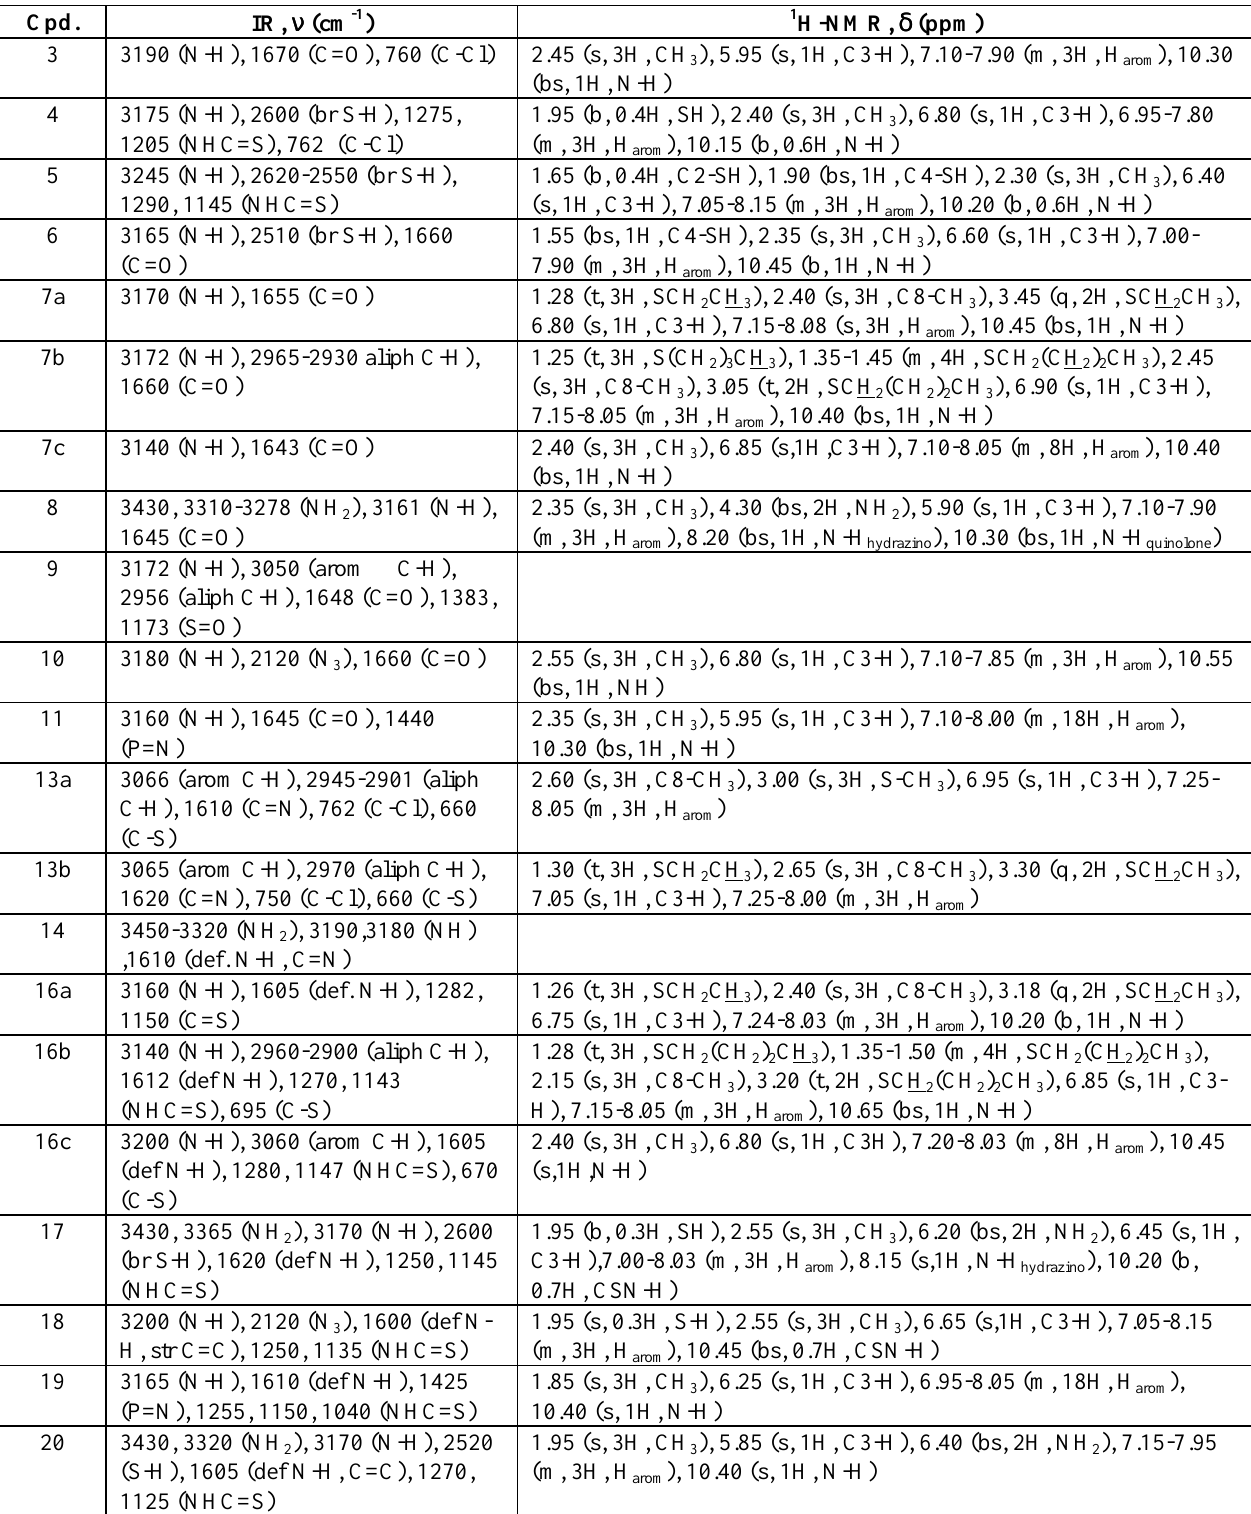
Table 2. IR and 1 H-NMR spectra of the new